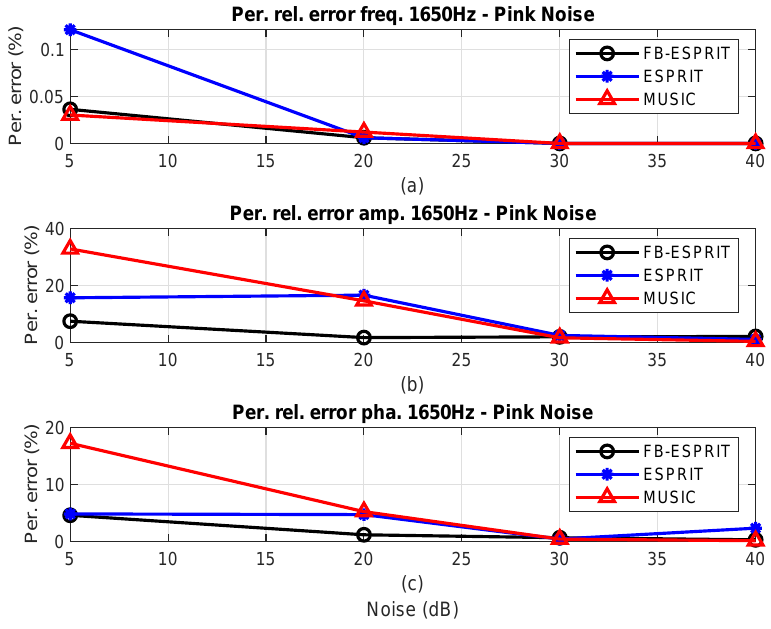
Figure 14. Percentage error (%) of the 1650 Hz component when signal s 2 ( t ) is contaminated with pink noise: ( a ) frequency parameters; ( b ) amplitude parameters; ( c ) phase parameters.